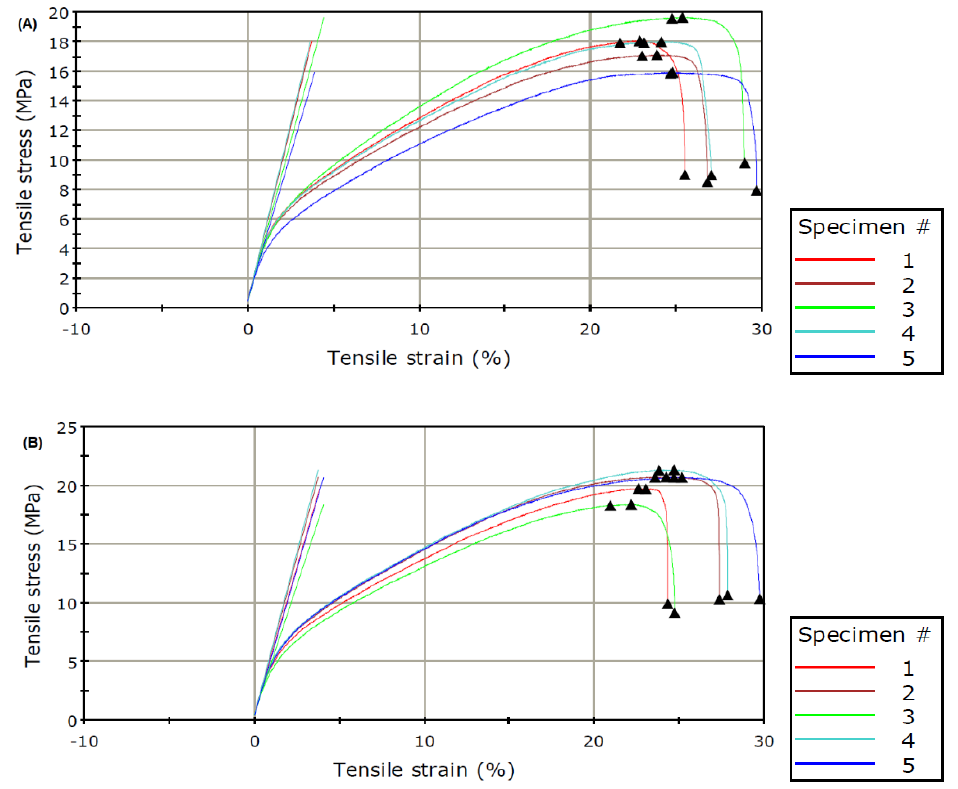
Figure 4. Stress-strain curves for the PA ( A ) and PA-CNC ( B ) membranes. The Figures shows a higher average tensile stress for PA-CNC than the value obtained for PA.